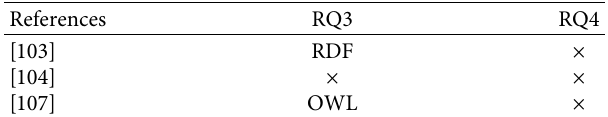
Table 10: Summary of Semantic Web technologies used in reg- ulatory conditions.